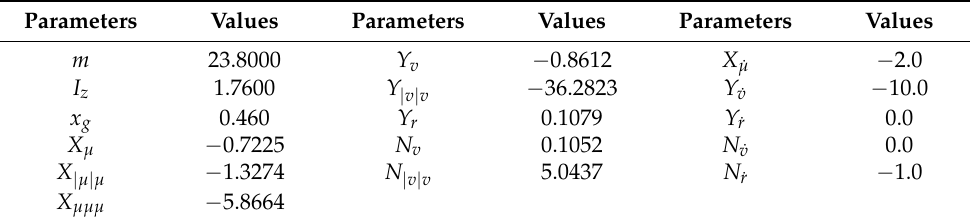
Table 2. The parameters of